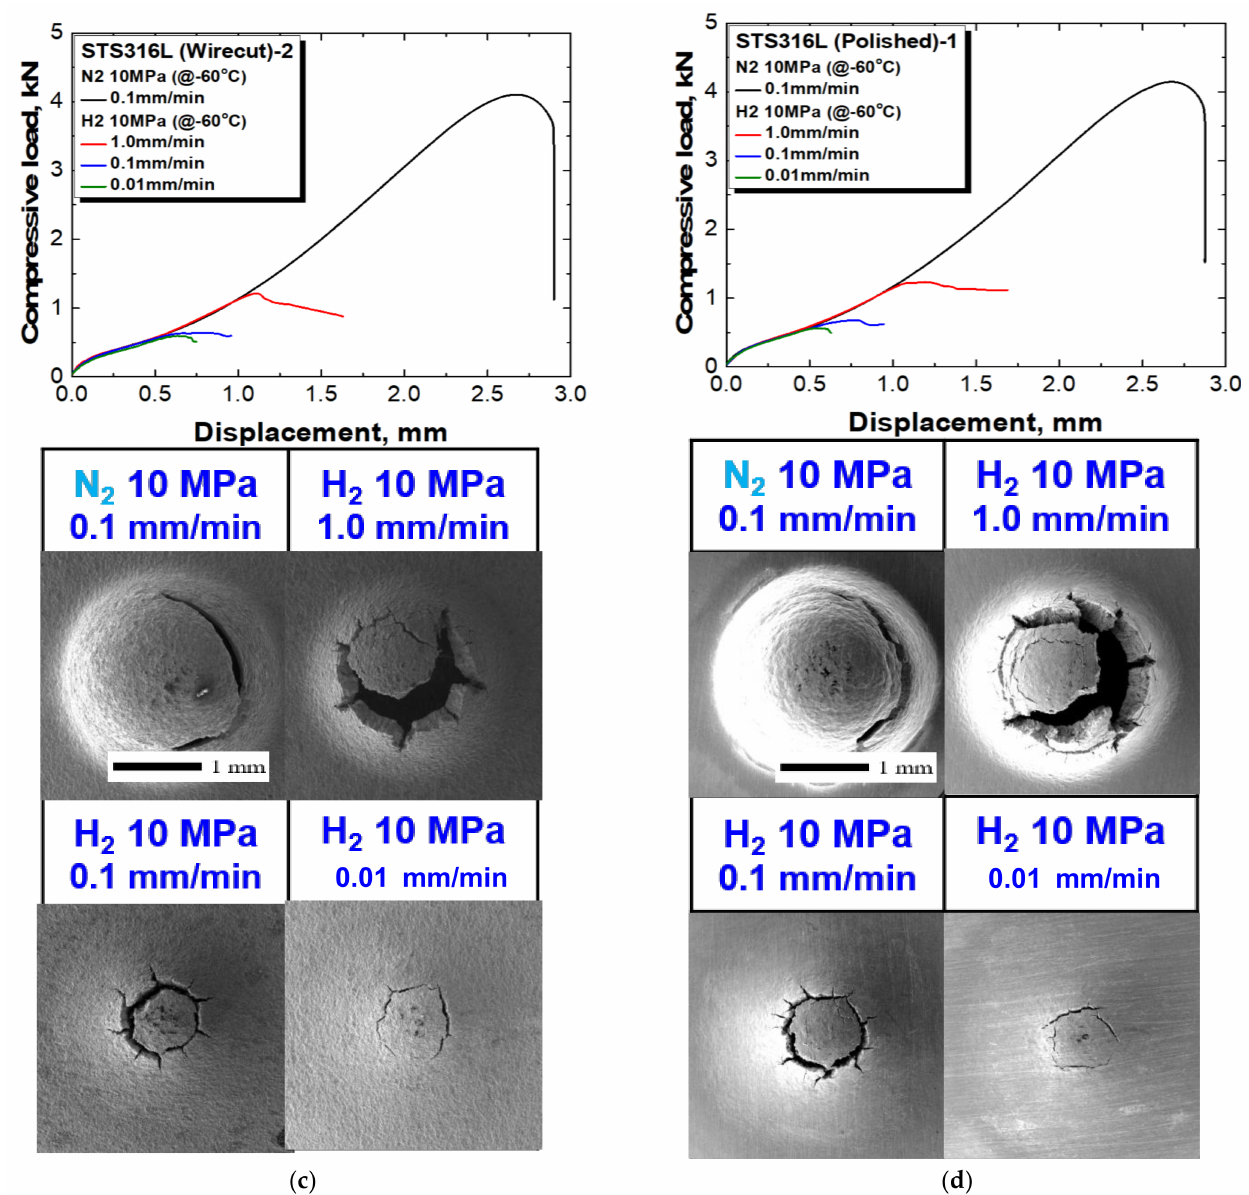
Figure 3. Load-displacement curves and fracture morphologies obtained for STS316L steel specimens of two surface finishes, tested under various conditions. ( a ) Wirecut at RT; ( b )Polished at RT; ( c ) Wirecut at − 60 ◦ C; ( d ) Polished at − 60 ◦